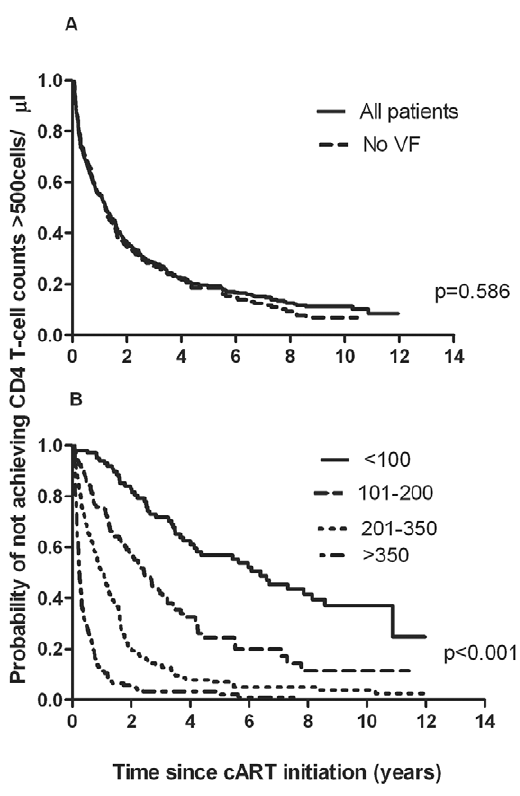
Figure 2. Kaplan-Meier plots showing time taken to achieve CD4 T-cell counts . 500 cells/ m l following cART initiation. Kaplan-Meier plots showing time taken to achieve CD4 counts . 500cells/ m l among (A) patients in the total cohort (n=501) and patients with no evidence of virological failure (VF) (2 consecutive HIV RNA . 500copies/ml) throughout follow-up (n=331) and (B) all patients (n=501) stratified by baseline CD4 T-cell counts ( , 100cells/ m l, n=99; 101–200cells/ m l, n=107; 201–350cells/ m l, n=172; . 350cells/ m l, n=123). Comparisons of survival curves were done using the Log-rank test (STATA